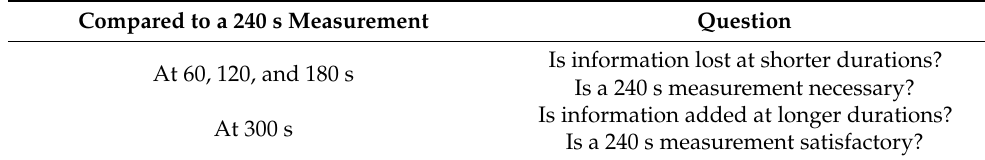
Table 2. Research questions on the enteric methane measurement duration for